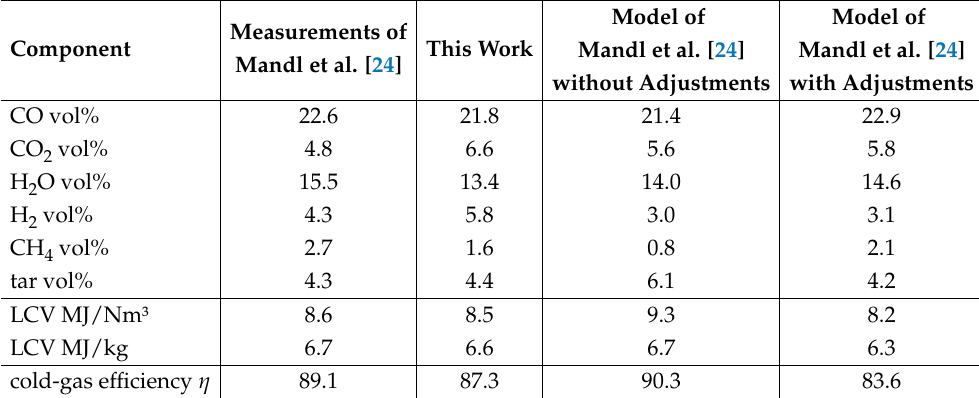
Figure 7. The predicted gas composition along the reactor height in 1D and 3D simulations. 3D predictions are averaged over the reactor diameter. Symbols indicate values measured at the gasifier outlet [24]. Table 6. The producer-gas composition at the gasifier